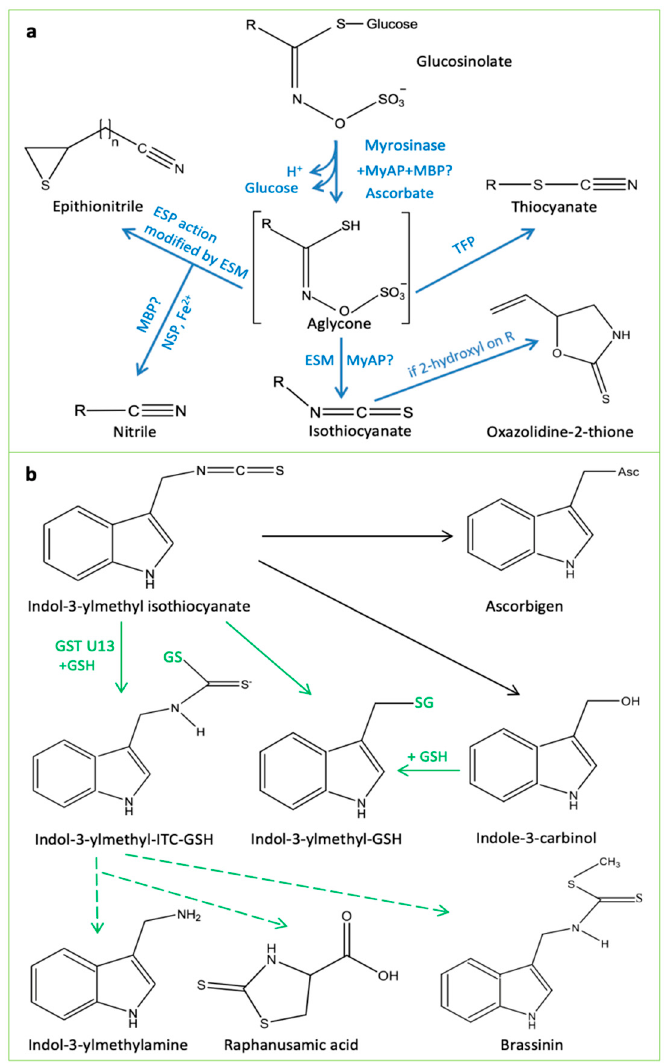
Figure 1. Glucosinolate structure and degradation products from the “mustard oil bomb”. Factors affecting formation of different biological active metabolites include potential myrosinase-interacting proteins, iron, glutathione, and glutathione S -transferase. ( a ) Sulfate is liberated in all reactions leading from the aglycone. Elemental sulfur (possibly S 8 ) is an additional product in the reaction forming a simple nitrile. The structures marked epithionitrile and oxazolidine-2-thione represent examples of these product types, depending on specific R-groups in the precursor glucosinolates. ( b ) The pathways in green represent putative indole ITC-derived products which lack biochemical evidence for activity (adapted from [25,26]). Black line represents a spontaneous reaction. ESM,